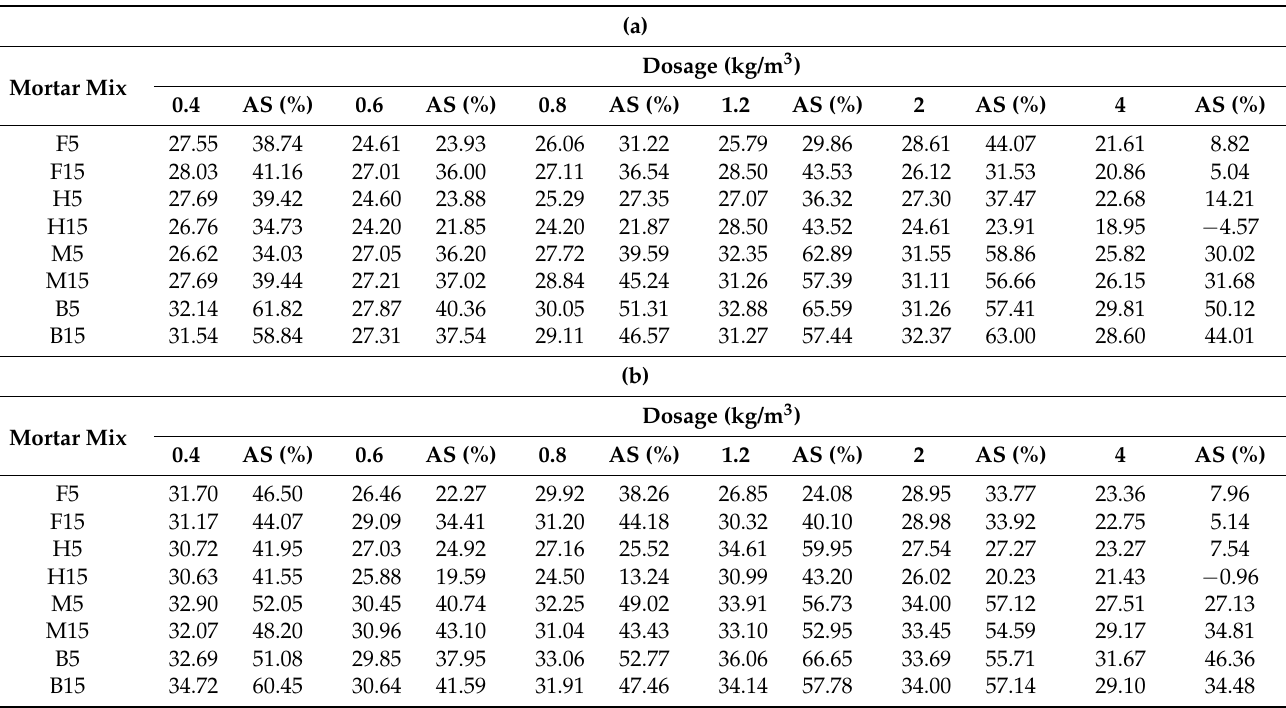
Table 10. ( a ) Compressive strength at 28 days (MPa) mean value measured on six specimens for each mortar mix. ( b ) Compressive strength at 90 days (MPa) mean value measured on six specimens for each mortar mix. AS: antifissuration screed mortar (0.6 kg/m 3 of fiber dosage)—Compressive strength range respect AS; Compressive strength AS: 19.86